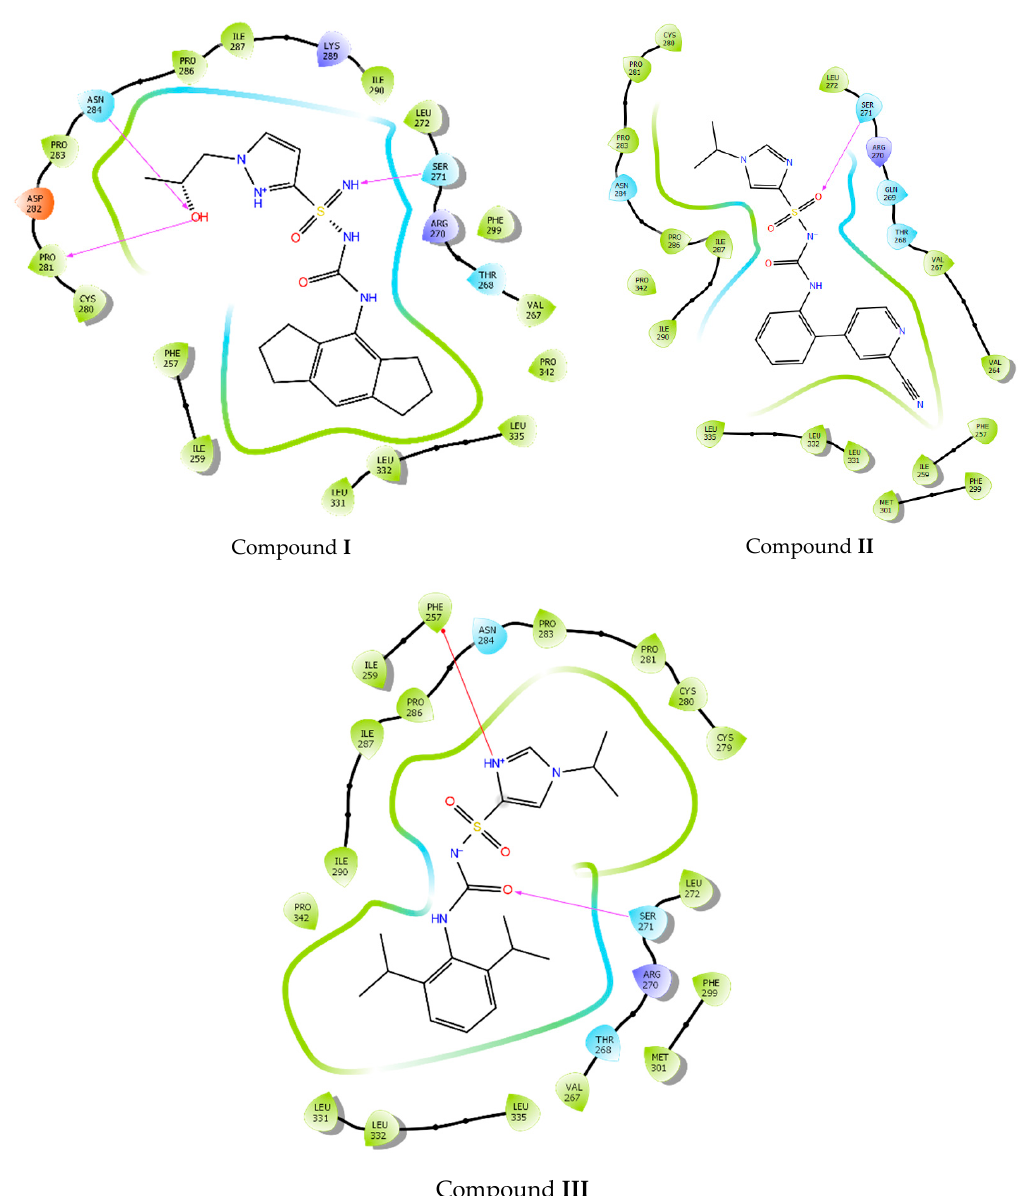
Figure 6. Ligand interaction diagram of compounds I , II , and III docked on the centered Walker B region. Purple arrows refer to H-bond interactions, green lines around molecule underline non-polar regions whereas the blue ones point polar residues.